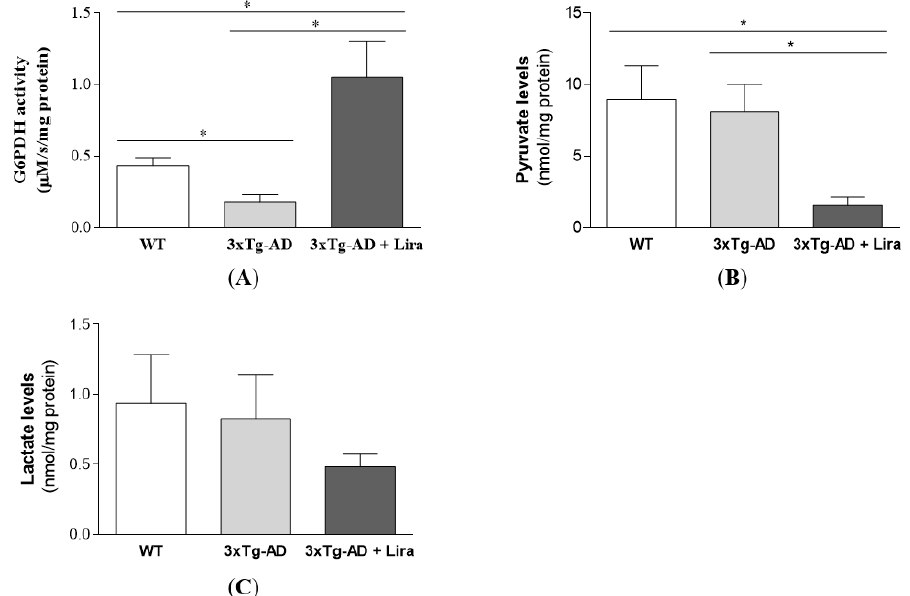
Figure 5. Effect of liraglutide on brain cortical glucose metabolism in female mice with early AD-like pathology. Brain cortical G6PDH activity ( A ), and pyruvate ( B ) and lactate levels ( C ) were determined. Data are the mean ± SE from 4–6 mice / group. Statistical significance: * p < 0.05, by the one-way ANOVA with the Fisher LSD post-hoc test for multiple comparisons (for a Gaussian distribution), or with the non-parametric Mann-Whitney test (for a non-Gaussian distribution: GAPDH activity and lactate levels).